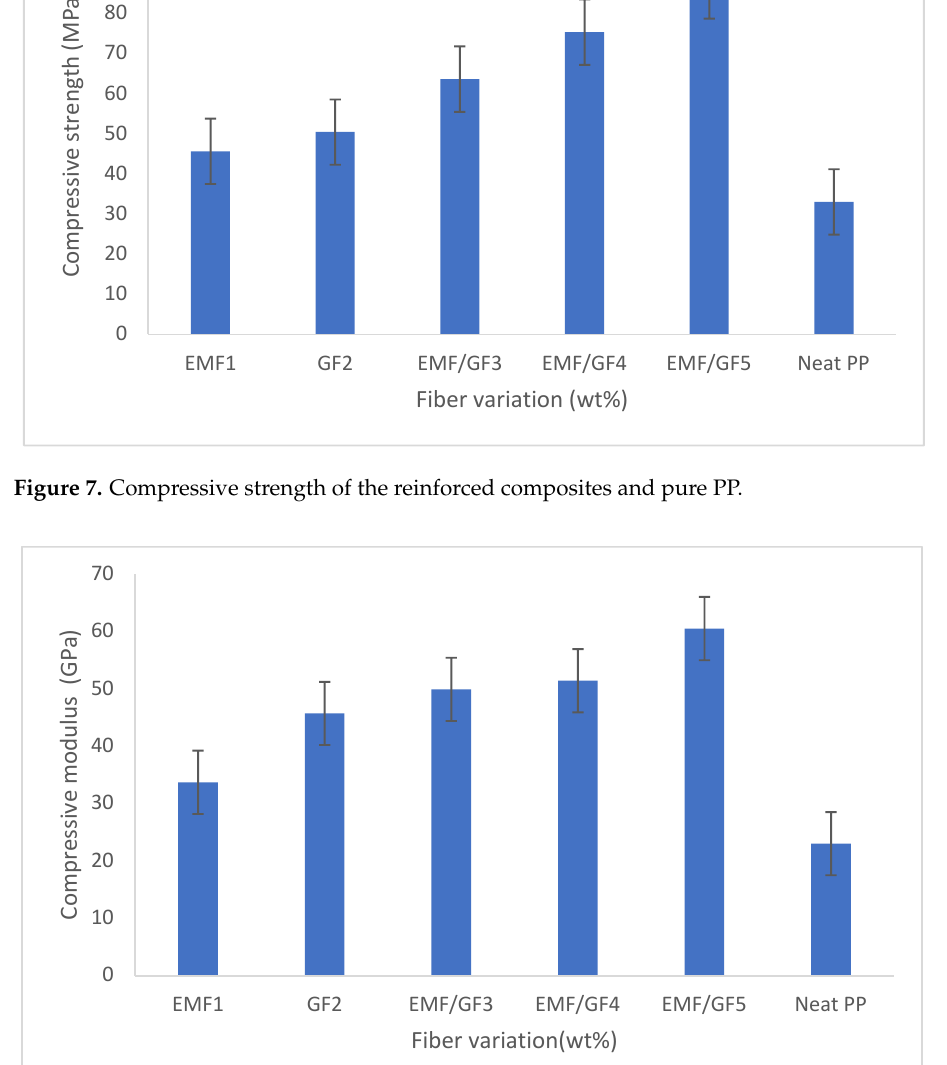
Figure 9. Impact strength of single and hybrid composites.